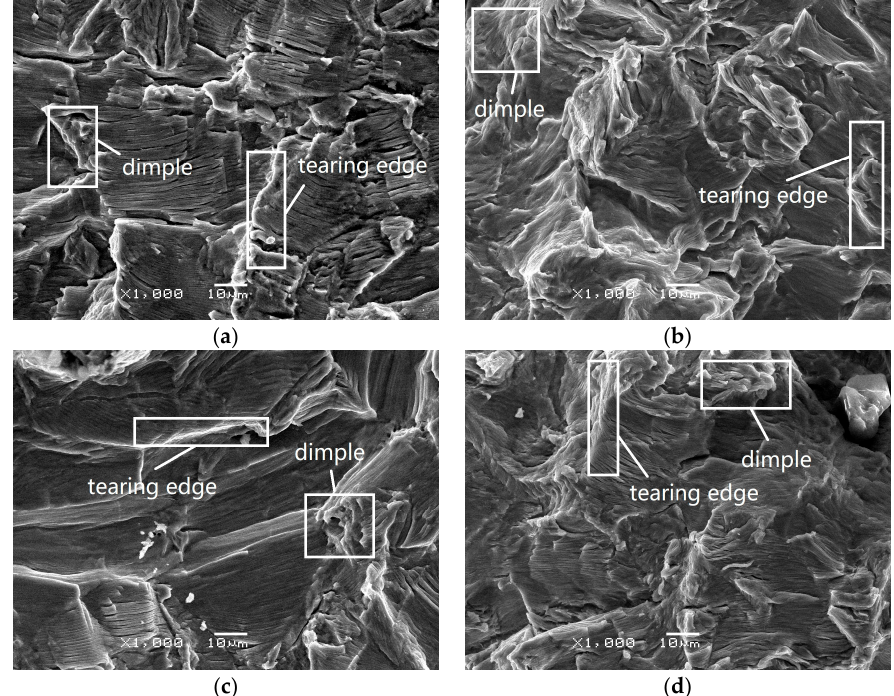
Figure 17. Typical SEM micrographs showing dwell fatigue fracture surface morphology in the final stage at different temperatures under high load ratio: ( a ) room temperature, t d = 0 s; ( b ) T = 300 °C, t d = 0 s; ( c ) room temperature, t d = 10 s; ( d ) T = 300 °C, t d = 10 s.